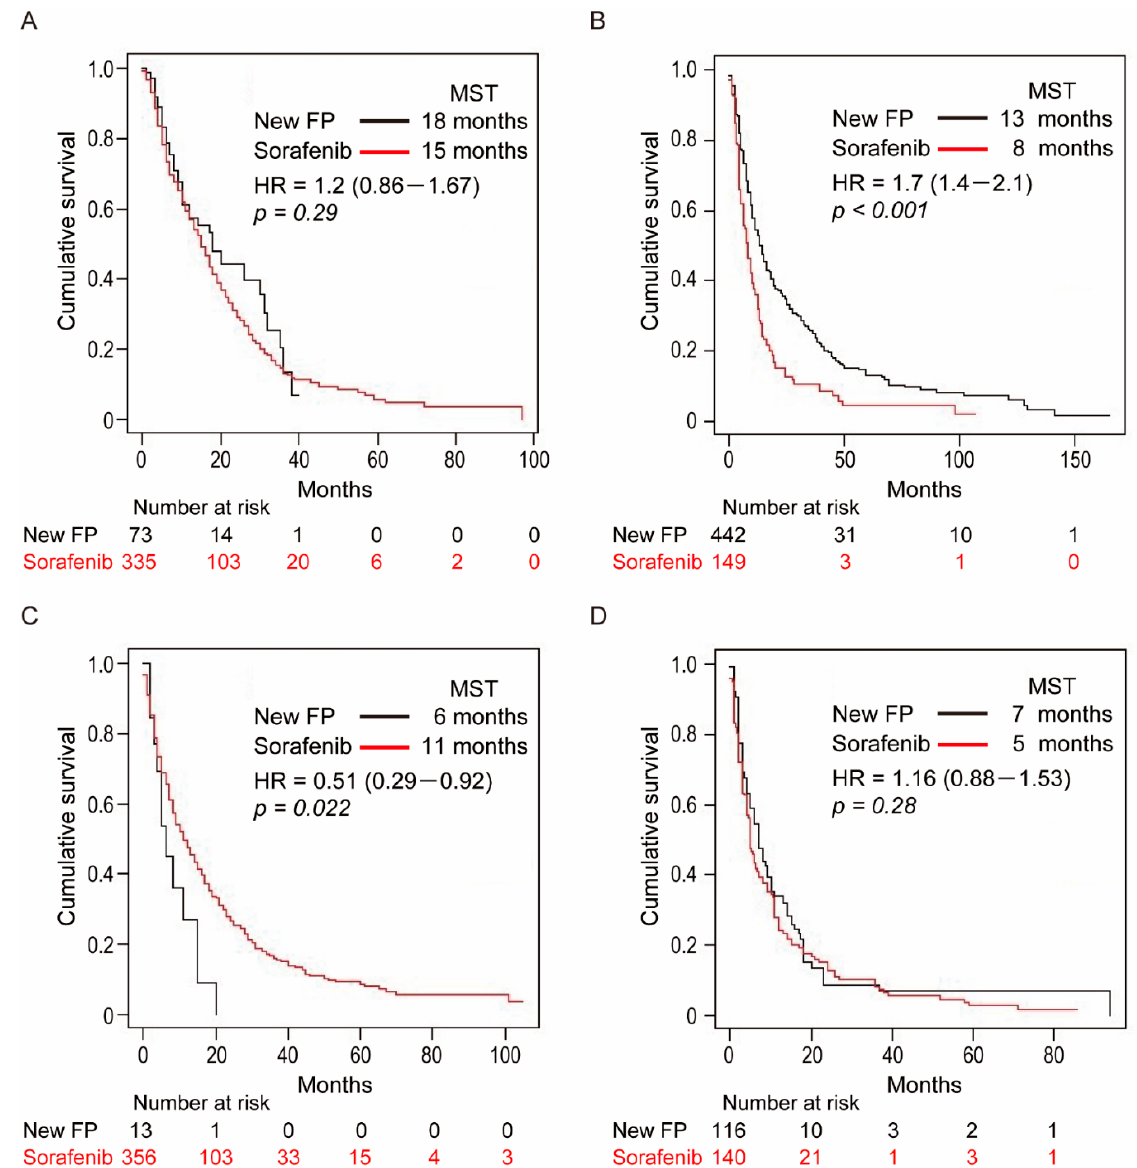
Figure 4. Overall survival curves of patients in the New-FP and sorafenib groups after subgroup analysis. ( A ) Cohort-1 (without MVI and without EHS), New-FP ( n = 73, black line) and sorafenib ( n = 335, red line), p = 0.29. ( B ) Cohort-2 (with MVI and without EHS), New-FP ( n = 442, black line) and sorafenib ( n = 149, red line), p < 0.001. ( C ) Cohort-3 (without MVI and with EHS), New-FP ( n = 13, black line) and sorafenib ( n = 356, red line), p = 0.022. ( D ) Cohort-4 (with MVI and with EHS), New-FP ( n = 116, black line) and sorafenib ( n = 140, red line), p = 0.28. Abbreviations: MVI, macrovascular invasion; EHS, extrahepatic spread; MST, median survival time; HR, hazard